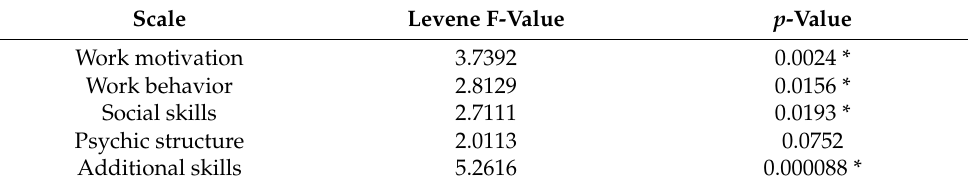
Table 18. Levene test statistics when the sample is differentiated by years of teaching experience. Scale Levene F-Value p -Value